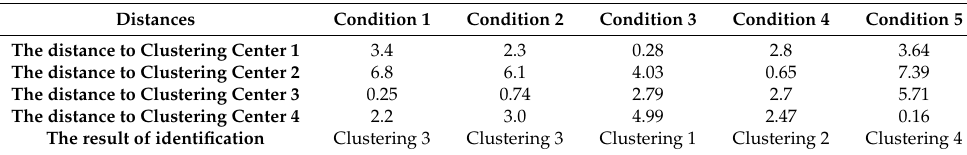
Table 6. The results of the